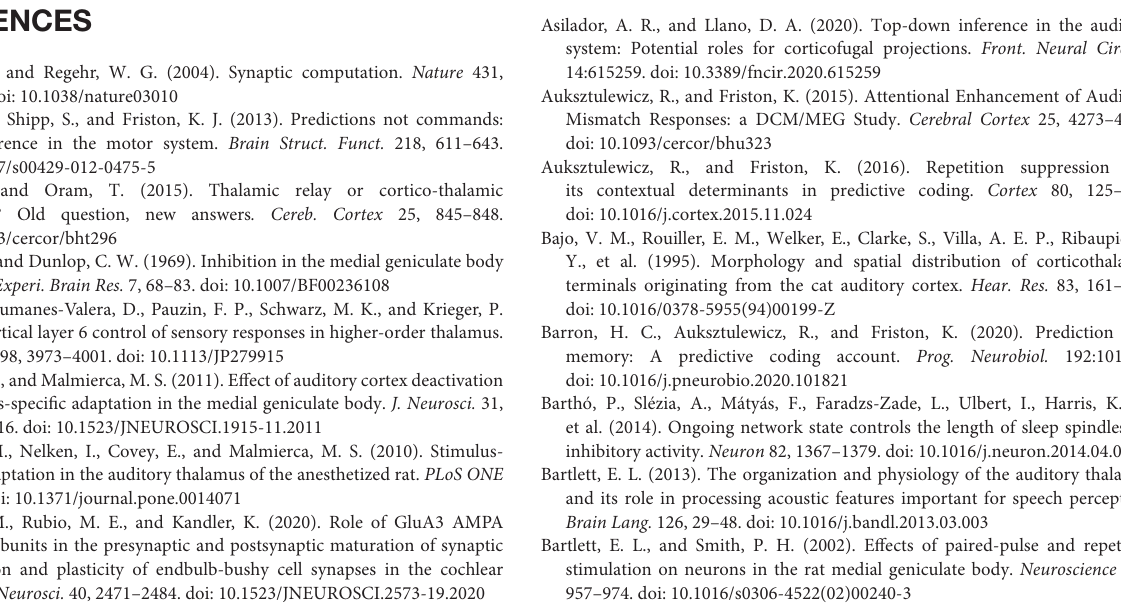
FIGURE 9 | corticothalamic pathways (both L6a and L5 CT projections) as key players in its implementation. A very interesting aspect of this model is the inclusion of deep pyramidal cells (presumably L5 CT cells) that convey the squared prediction error (second-order forward connections) to enable the pulvinar (matrix cells) to estimate precision. These cells in the pulvinar send back projections to modulate the gain of superficial pyramidal cells in the cortex. Red, forward connections; Black, backward connections; Full lines, first order streams; Dashed lines, second order (precision-related) streams. CT, corticothalamic; L5, cortical layer 5; L6a, cortical layer 6a. Adapted from Kanai et al.